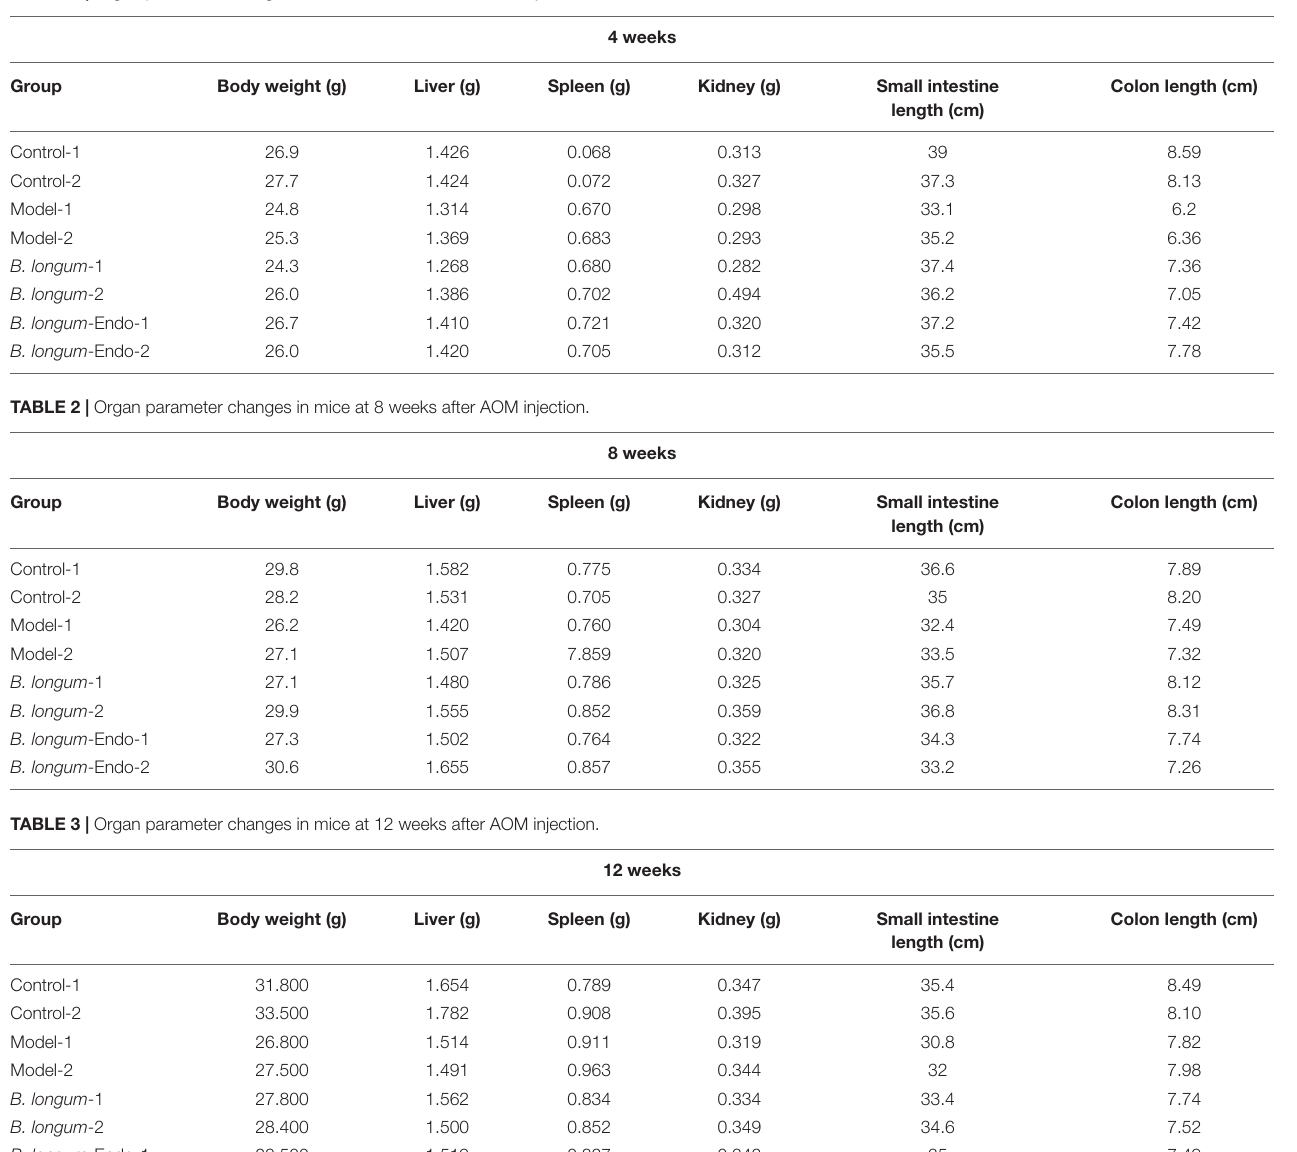
TABLE 1 | Organ parameter changes in mice at 4 weeks after AOM injection.